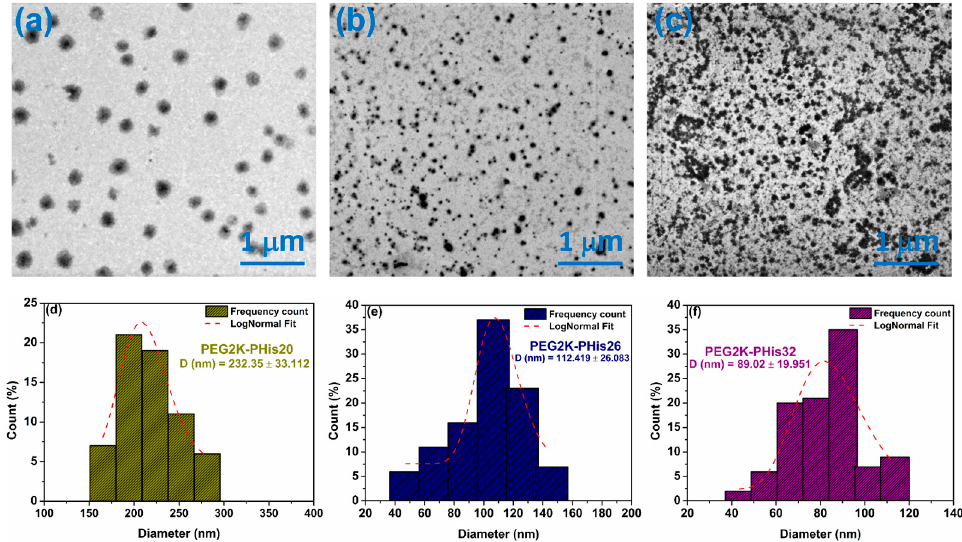
Figure 4. Scanning transmission electron microscopy images of unloaded micelles ( a – c ) and distribution of diameters ( d – f ).